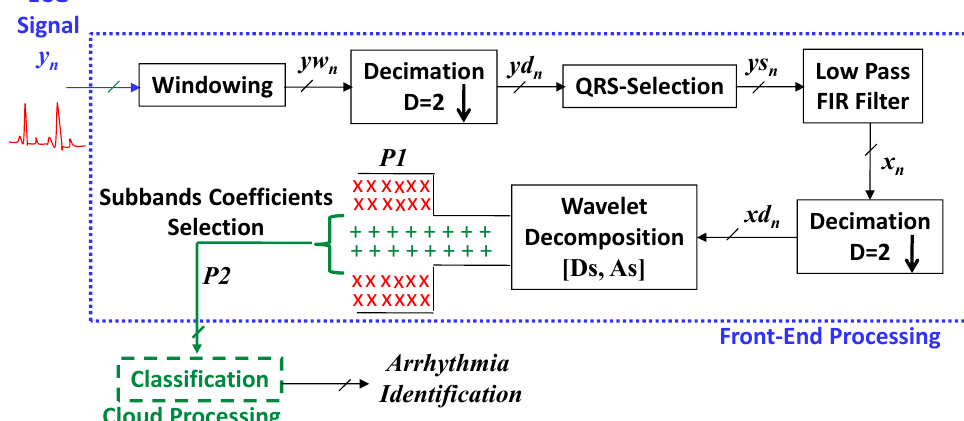
Figure 1. The proposed system block diagram.